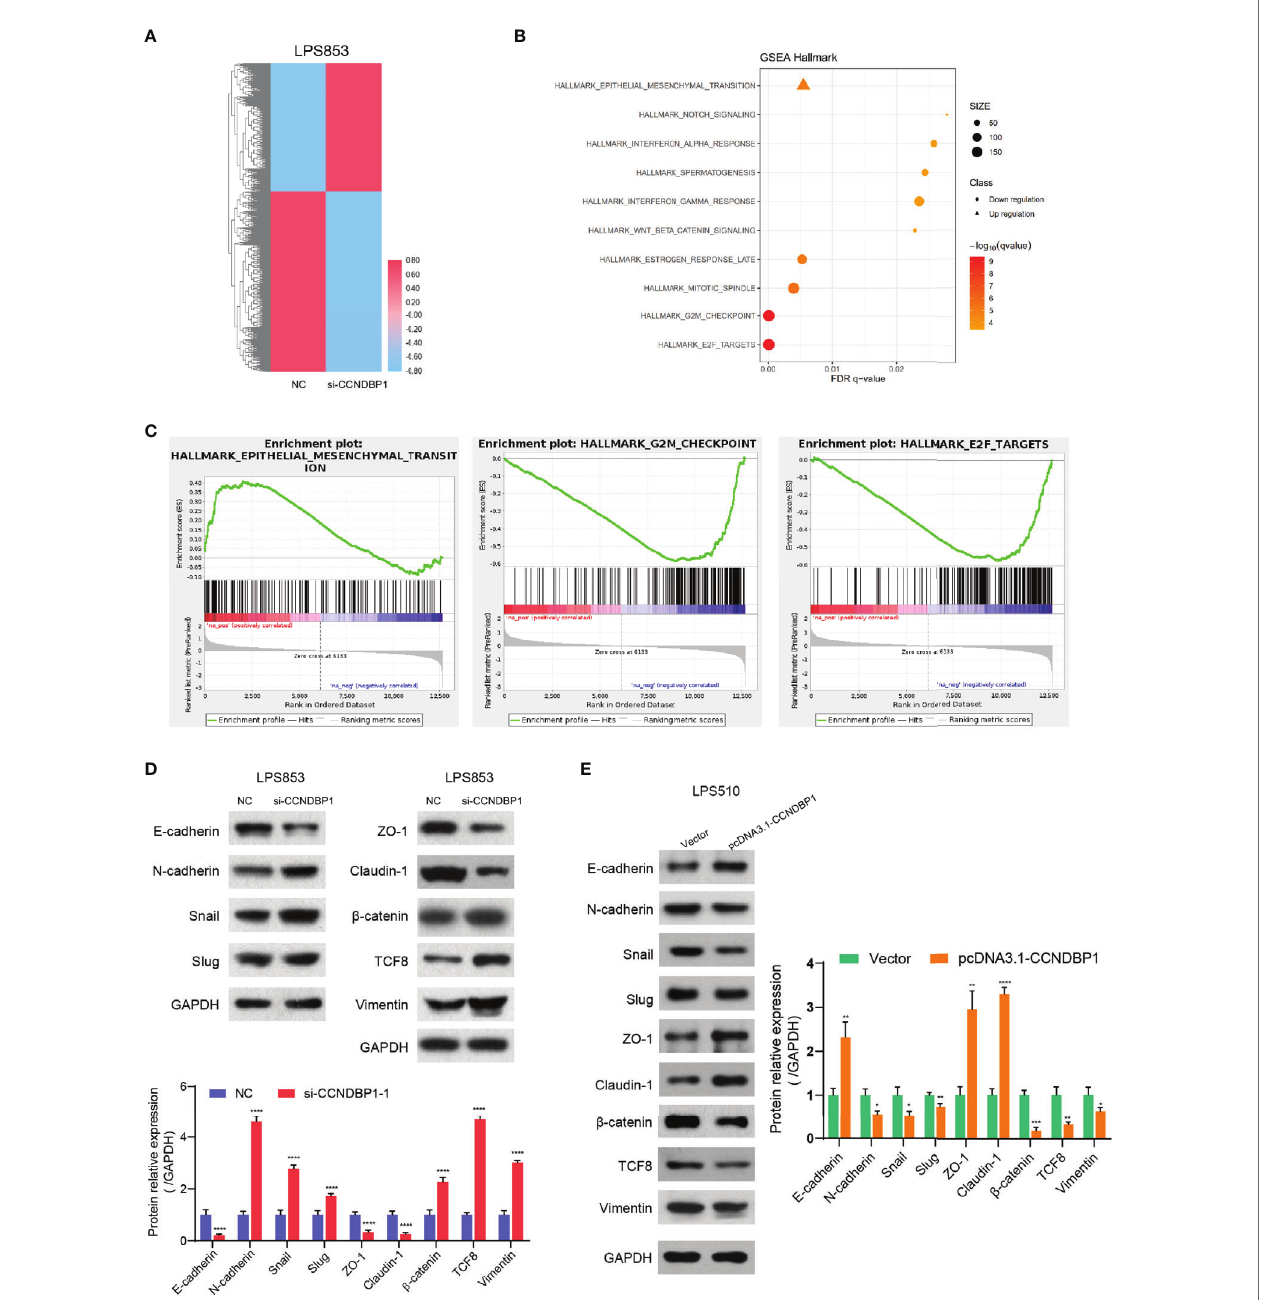
FIGURE 6 | CCNDBP1 could regulate the malignant potentials of DDL cells by repressing the pathological EMT. (A) The heatmap of gene expression after the interference of CCNDBP1 expression by siRNA in LPS853 cells. NC as the control, red for upregulation and blue for downregulation; (B) Gene function annotation cluster of the GSEA Hallmarks. Clusters with a statistical signi fi cance (FDR q < 0.05) were mainly marked; (C) The result subset of GSEA, mainly involving the EMT, E2F targets, and G2M checkpoints; (D) Based on the Western blot experiments, the expression levels of the EMT-related markers were signi fi cantly changed after the interference of CCNDBP1 expression in LPS853 cells. The expressions of E-cadherin, ZO-1, and Claudin-1, proteins related with epithelial cell structures and tight junctions, were apparently downregulated; and the expressions of N-cadherin and Vimentin, markers related with mesenchymal cell status, were apparently upregulated. The expressions of TCF-8, b -catenin, Snail, and Slug, which were transcription factors related with pathological EMT, were apparently upregulated; (E) The expression levels of EMT-related markers were signi fi cantly changed after CCNDBP1 overexpression in LPS510 cells. The expression of E-cadherin, ZO-1, and Claudin-1 proteins related to epithelial cell structures and tight junctions, was upregulated, while the expression of N-cadherin and Vimentin markers related to the mesenchymal cell status was downregulated. In addition, the expression of TCF-8, b-catenin, Snail, and Slug, transcription factors related to the pathological EMT, were downregulated. GAPDH as the control; *P < 0.05; **P < 0.01; ***P < 0.001; ****P <